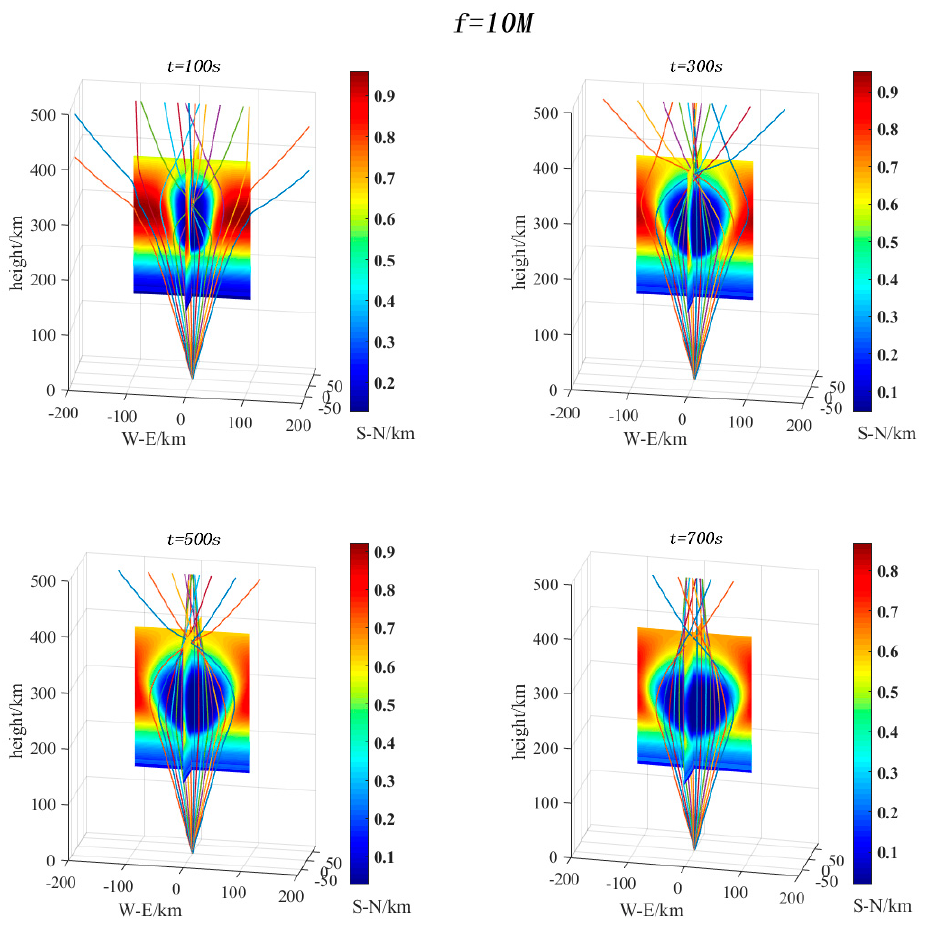
Figure 9. The 3D ray tracing simulation of 10 MHz shortwave echo path after CO 2 release of 100 s, 300 s, 500 s and 700 s (electron density unit: 10 6 cm − 3 ).